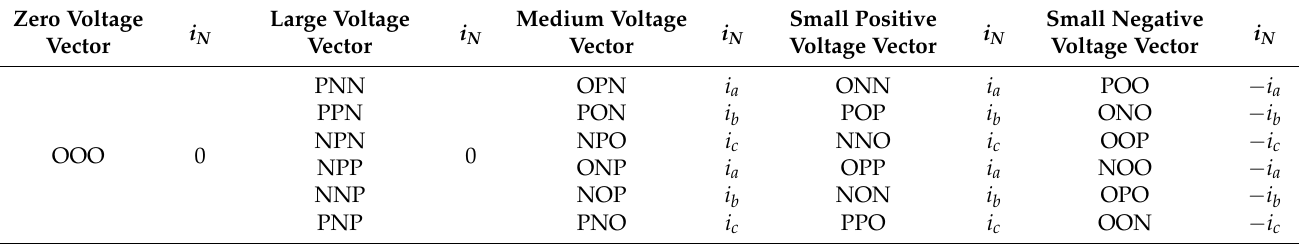
Table 1. Corresponding i N of different